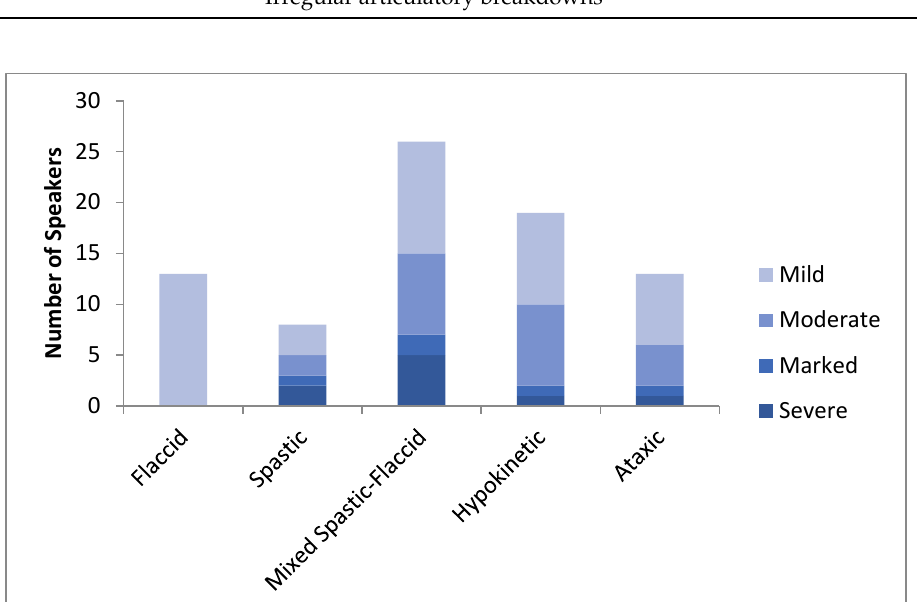
Figure 1. Distribution of participants according to dysarthria severity by dysarthria type.